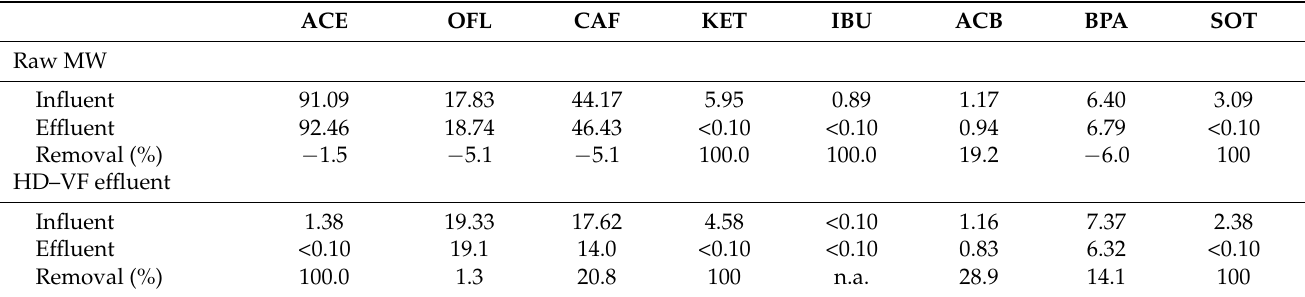
Table 6. Results for PD cell treating raw MW and HD–VF